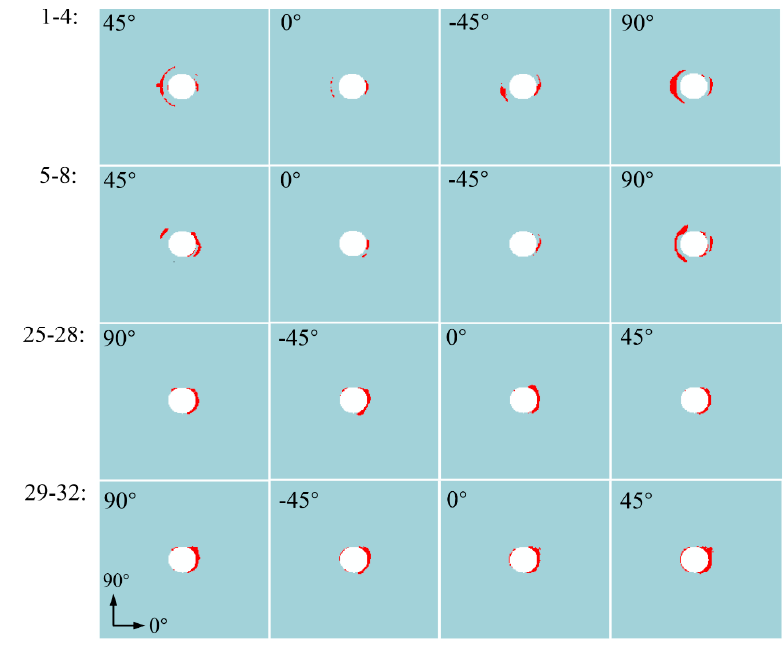
Figure 14. Thin-ply-laminated matrix damage state at point Figure 14. Thin − ply − laminated matrix damage state at point B.